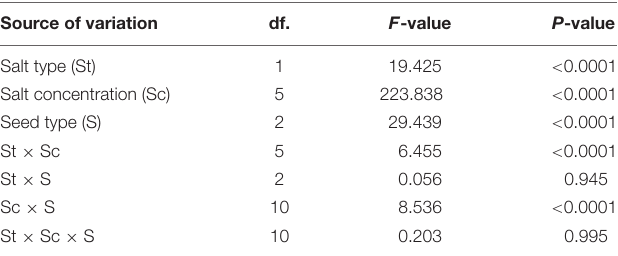
TABLE 5 | Three-way ANOVA of effects of salt type, salt concentration, seed type and their interactions on seed germination of S. ferganica. Source of variation df. F